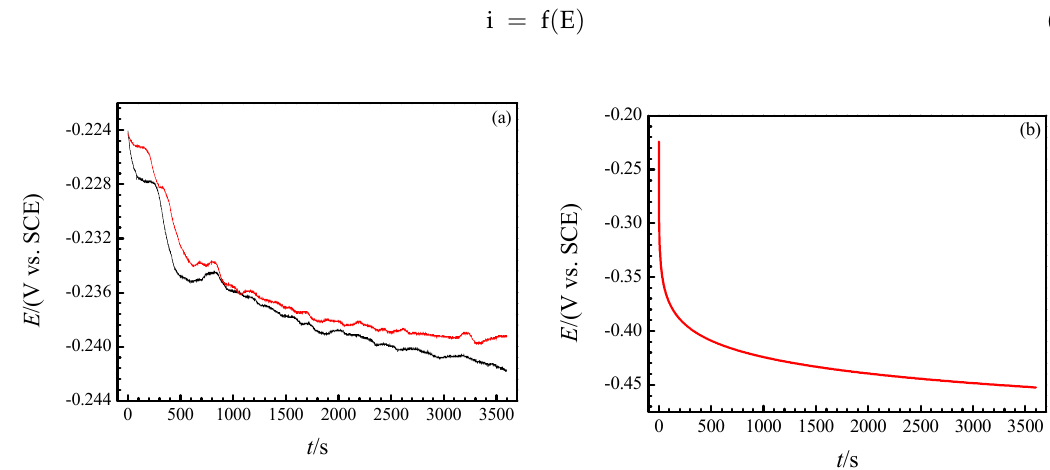
Figure 5. Experimental OCP diagram of copper electrode in neutral 3.5% (wt.) NaCl solution at room temperature during the 1st h ( a ) and corresponding theoretical one ( b ).